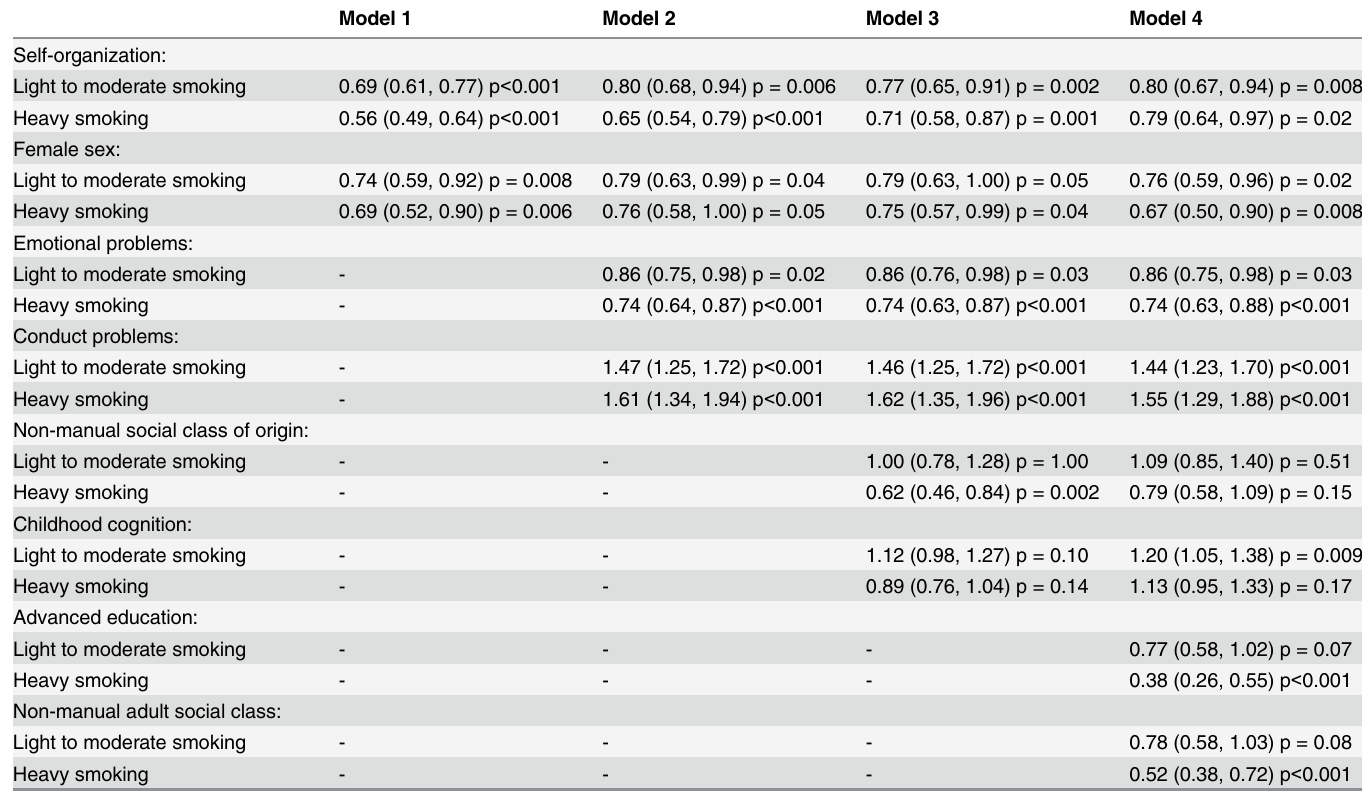
Table 2. Multinomial logistic regression coefficients for odds of light to moderate and heavy smoking pack years (ref. = lifetime